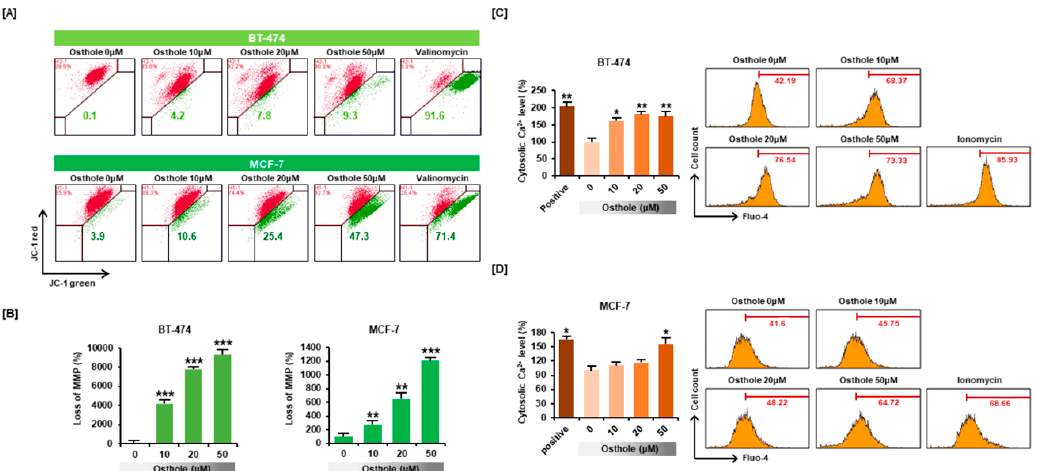
Figure 3. Effects of osthole on mitochondrial dysfunction and cytosolic calcium influx in human breast cancer cells. ( A , B ) Mitochondrial membrane potential (MMP) was evaluated in JC-1 stained BT-474 and MCF-7 cells using flow cytometry. Depolarization of mitochondria was indicated by increased green fluorescence in the dot plot. The cells treated with Valinomycin (1 μ g/mL) for 20 min were used as a positive control for mitochondrial depolarization. ( C , D ) Calcium levels in the cytoplasm were evaluated using the cytosolic calcium indicator, Fluo-4. The cells treated with Ionomycin (12 μ M) for 5 min were used as a positive control for calcium flux. All experiments were performed in biological triplicate and the asterisks represent statistically significant differences compared to vehicle-treated cells (* p < 0.05, ** p < 0.01 and *** p < 0.001).